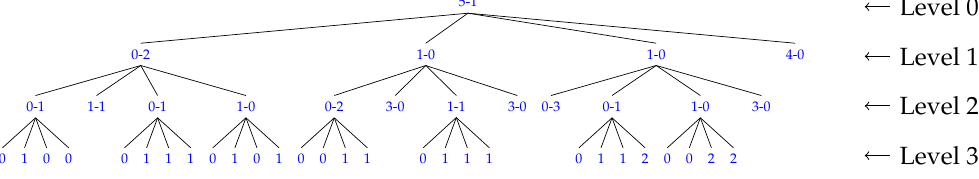
Figure 11. Based on the tree in Figure 10, the maximum value of each node is subtracted from that of its parent while the minimum value of the parent is subtracted from the node’s minimum value. These differences will replace their corresponding values in the node. The maximum and minimum values of the root remain the